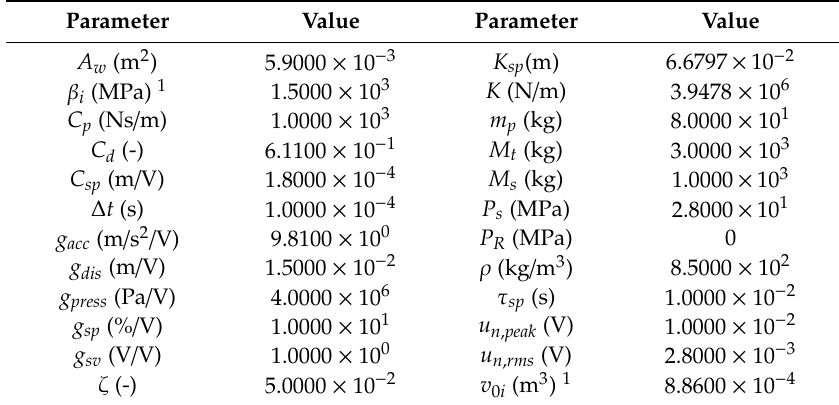
Table 1. Values of parameters used in the considered